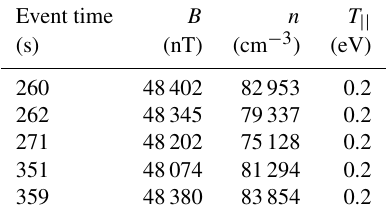
Table 4. Parameters used for computing dispersion surfaces in WHAMP associated with Langmuir bursts labeled in Figs.